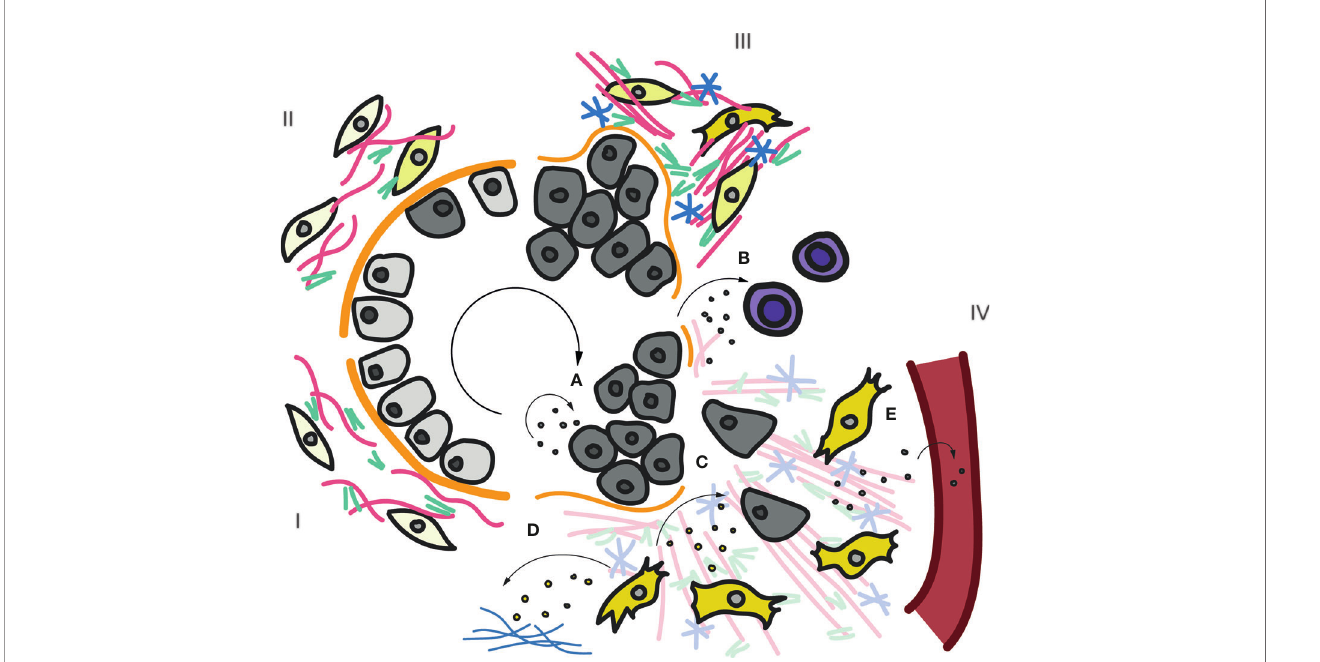
FIGURE 5 | Roles of exosomal TnC in cancer progression and immunomodulation. Scheme of the main stages (I-IV) in carcinoma tumor progression. In stage I a normal epithelium is shown, composed by epithelial cells located on a basal membrane. Underneath, the interstitial matrix deposited by stromal cells provides support. Insults promote transformation of epithelial cells onto tumoral cells, which lose polarity and adhesion (Stage II). In stage III, continuously activated fi broblasts increase the production and secretion of ECM, including collagens, FN and TnC. Tumor cells start invading neighbouring tissues and degrading the basal membrane. Finally, in stage IV, a highly remodelled ECM favors tumor cell migration through the interstitial space towards blood and lymphatic vessels, to metastasize. The previously described roles of exosomal TnC in tumor progression are depicted (A – E) . (A) Paracrine/autocrine secretion of TnC-loaded exosomes induce tumor cell proliferation and invasion (122). (B) Exosomal TnC derived from brain tumour-initiating cells suppresses mTOR activity and T-cell activity (219)(Mirzaei et al). Activated fi broblasts can also secrete exosomes carrying TnC that can (C) modulate tumor cells and/or deposit new TnC matrix (108) (D) . Finally, TnC-positive exosomes can be released into the bloodstream to deposit TnC at distant organs (E) . An increase in TnC in plasma has been proposed as poor prognosis marker in many cancers and in fl ammatory diseases